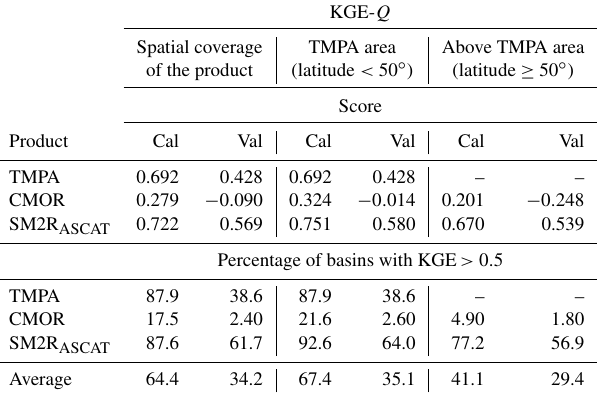
Table 3. Median KGE- Q index computed by comparing Q E-OBS simulated data against simulated discharge data obtained by forcing the MISDc hydrological model with satellite (TMPA, CMOR and SM2R ASCAT ) rainfall data. The percentage of the basins showing KGE- Q values higher than 0.5 is also listed. Performances and per- centages are averaged over different spatial windows, i.e. the orig- inal spatial coverage of the product and over or above the TMPA area (latitude ± 50 ◦ ). Note: Cal – calibration period; Val – valida- tion period. KGE- Q TMPA